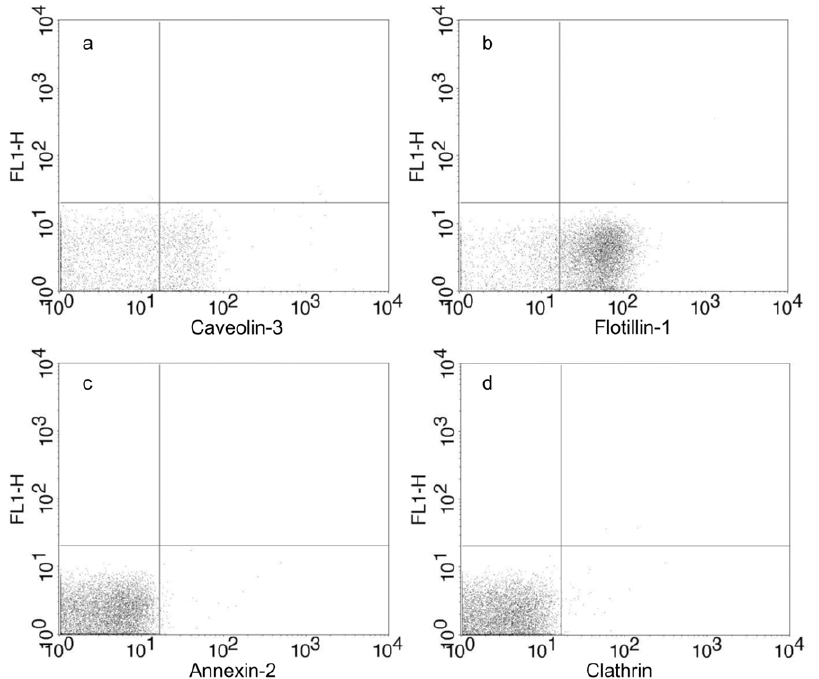
Figure 2. Detection of proteins on microvesicle/exosome surface with flow cytometry. Microvesicles/exosomes prepared from Claycomb culture medium was incubated with antibodies conjugated with phycoerythrin (PE). A) Mouse anti-caveolin-3, was detected on approximately 30% of the microvesicles/exosomes. B) Mouse anti-flotillin-1, was detected on approximately 80% of the microvesicles/exosomes. C) Mouse anti-annexin-2, was not detected on the microvesicles/exosomes. D) Mouse anti-clathrin heavy chain, was not detected on the microvesicles/exosomes. The distribution of exosomes presenting caveolin-3 and flotillin-1 indicates that the sample contains more than one population of microvesicles/exosomes.